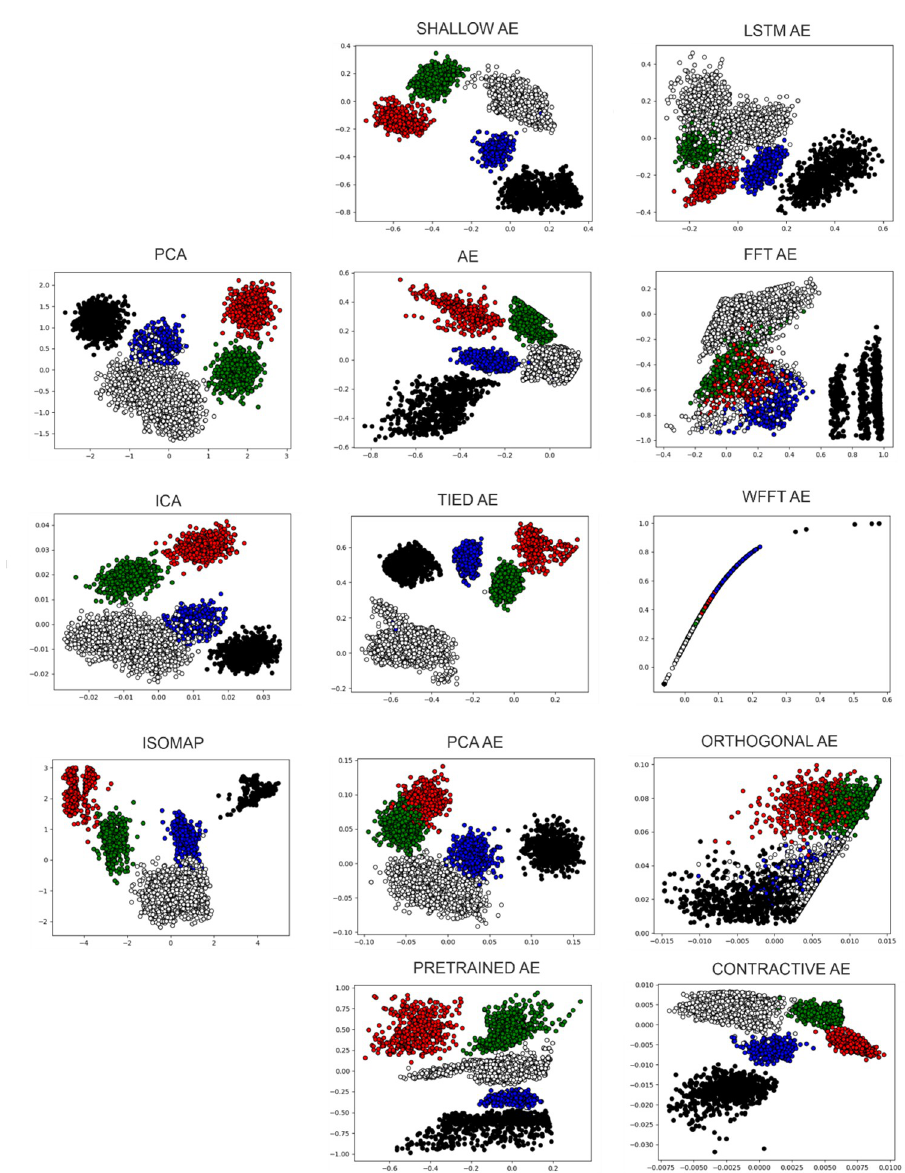
Fig 6. Feature extraction of the Sim4 dataset. All feature extraction methods applied on Sim4; the colors present the ground truth. The Sim1 dataset is one of the more difficult ones. It presents a high number of clusters, 17 in number, that have some similarities in spike shapes resulting in a high amount of overlap between clusters. This is shown in both the plots displayed in Fig 7 as in the performance eval- uations of Table 6. State-of-the-art methods are able to completely separate a low number of clusters. PCA and ICA only manage to separate 2 clusters, whilst the rest are coalesced into an amalgamation. Isomap provides the highest number of separated clusters by any of the state- of-the-art methods used, with 5 clusters separated, but the same tendency to join the rest of the clusters remains and it clearly visible in Fig 7. Whereas a part of the autoencoder variants, such as the Shallow AE and AE variations, are able to separate up to 10 clusters with minimal